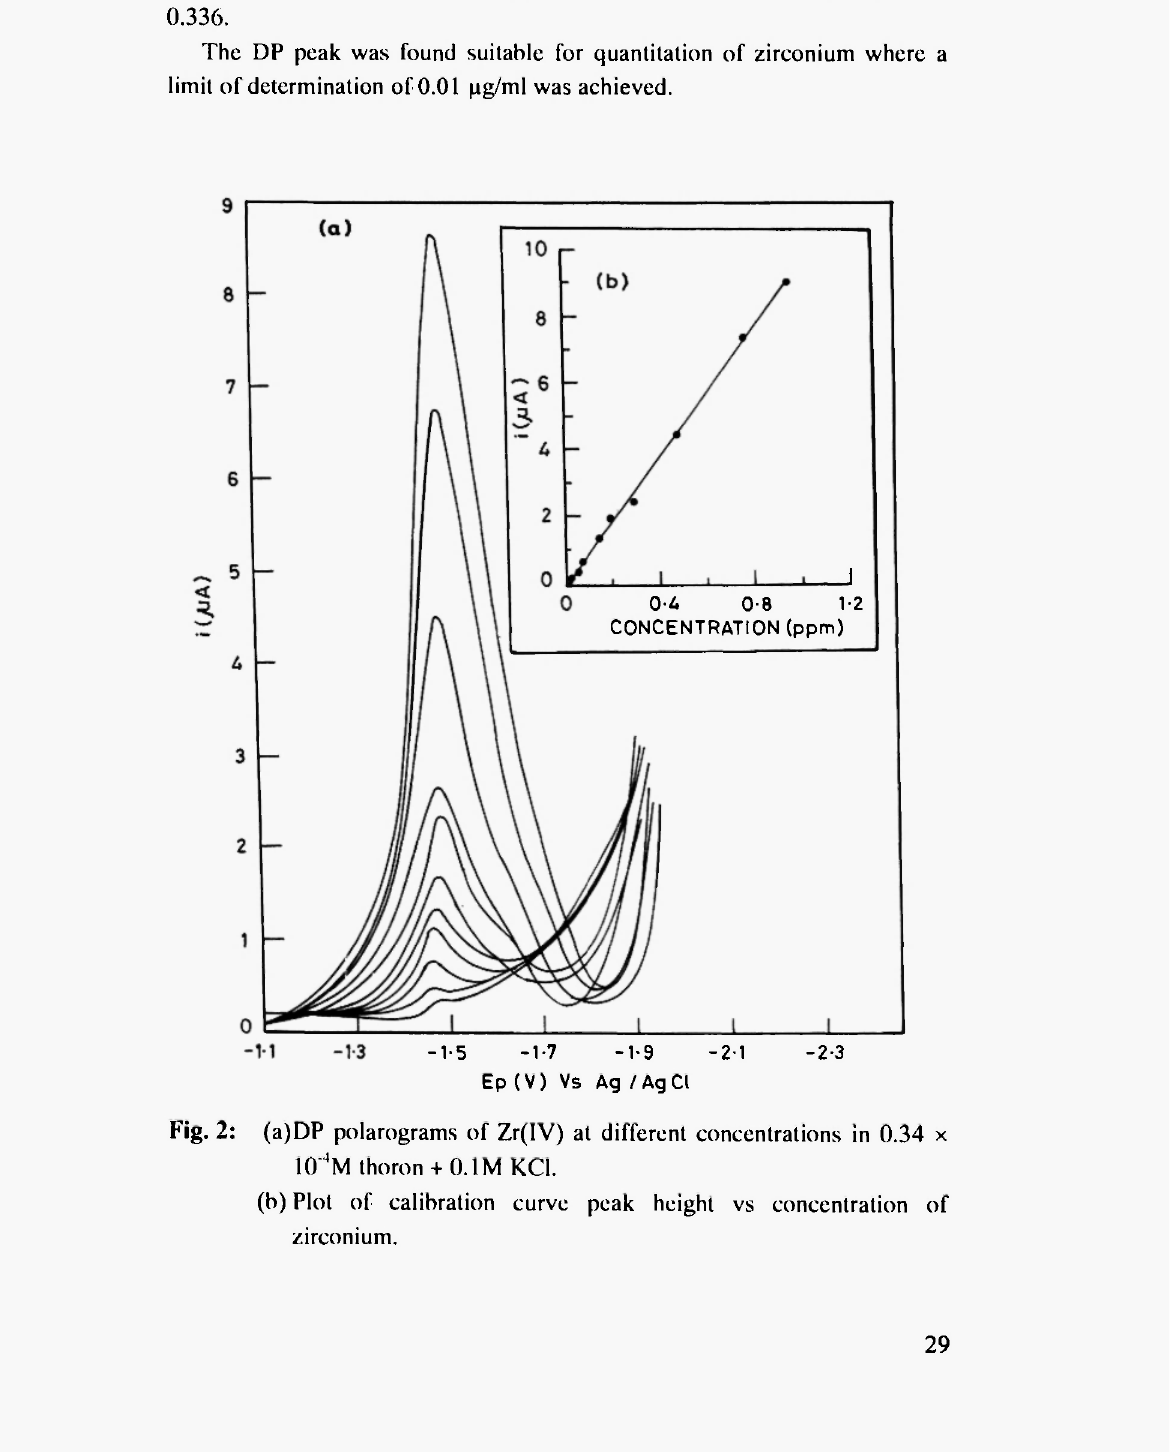
Fig. 2: (a)DP polarograms of Zr(IV) at different concentrations in 0.34 χ 10" 4 M thoron + 0.1Μ KCl. (b) Plot of calibration curve peak height vs concentration of